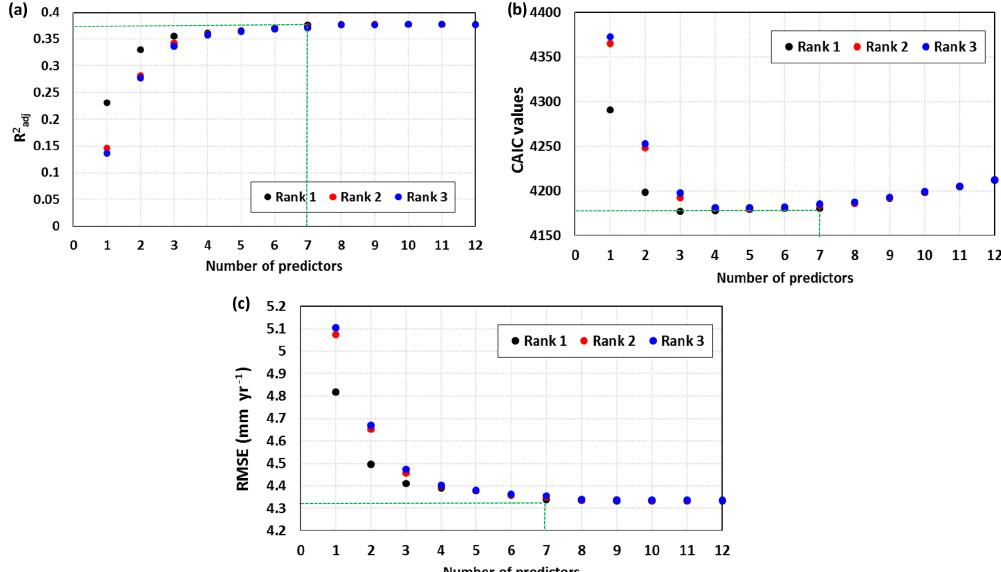
Figure 5. (a) R 2 , (b) CAIC and (c) RMSE for the top three models with 1 to 12 predictors and the green dotted lines representing the adj number of predictors for the best performance criteria value.